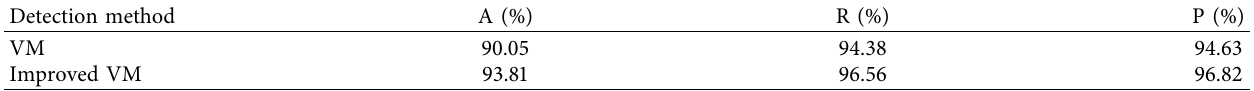
Table 4: Evaluation indices of the proposed method.